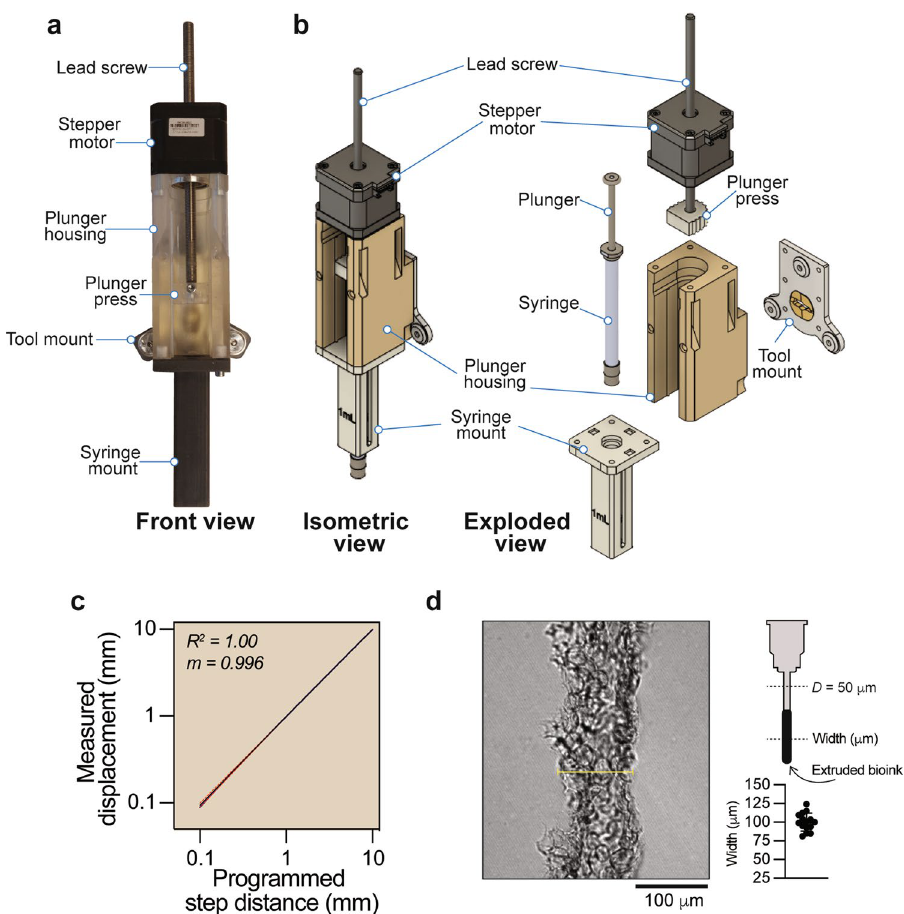
Figure 2. Design of the syringe pump extrusion tool. ( a ) A photograph of the assembled syringe pump extrusion tool. The syringe plunger is pushed down by a lead screw via a plunger press. The lead screw is linearly translated along the z-axis through a stepper motor, which is attached atop the 3D printed plunger housing. 3D printed exchangeable syringe mounts are attached to the base of the plunger housing, and the entire syringe pump extrusion tool is attached to the tool exchanger system via the E3D tool mount fixture. ( b ) Isometric and exploded views of CAD illustrations of the syringe pump extrusion tool. ( c ) Linear regression analysis comparing the vertical displacement (mm) of the syringe plunger as measured by a dial indicator with the intended step sizes 10 mm, 1 mm or 0.1 mm set on the stepper motor. Ten measurements were recorded for each step size (red dotted lines indicate S.D.). ( d ) A differential interference contrast image detailing a section of a collagen string bioprinted using the FRESH protocol through a needle with a cross-sectional diameter of 50 μm. Scatterplot of width measurements recorded from multiple locations along the length of the printed string (100 ± 12